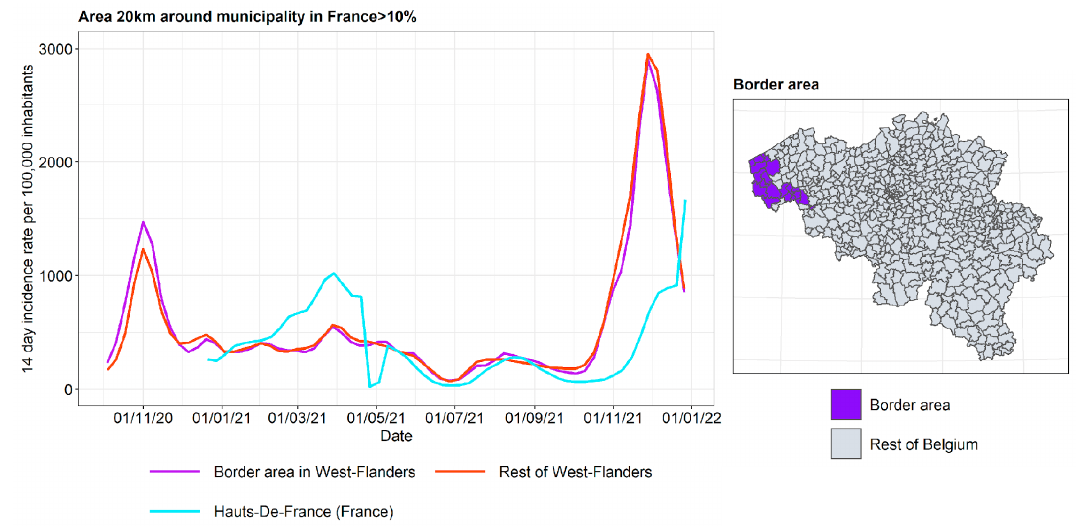
Figure 12. COVID-19 incidence curves for the border area with Hauts-De-France (France).